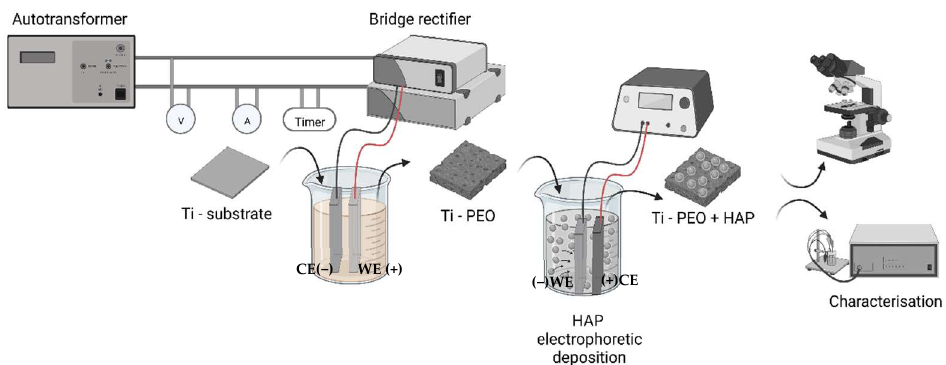
Figure 1. Schematic representation of the synthesis process (Created with BioRender.com–created on 12 January 2023).